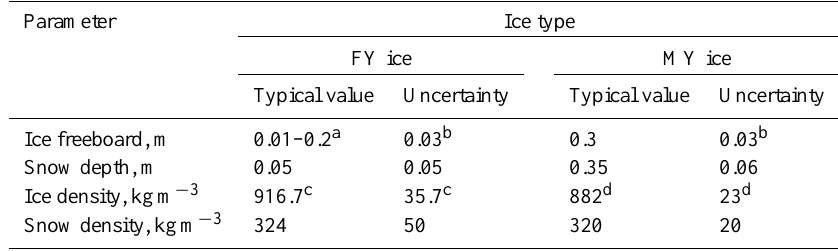
Table 1. Typical values and uncertainties of snow and ice density and snow depth for late winter conditions. The freeboard data are prescribed input to the hydrostatic equilibrium equation.